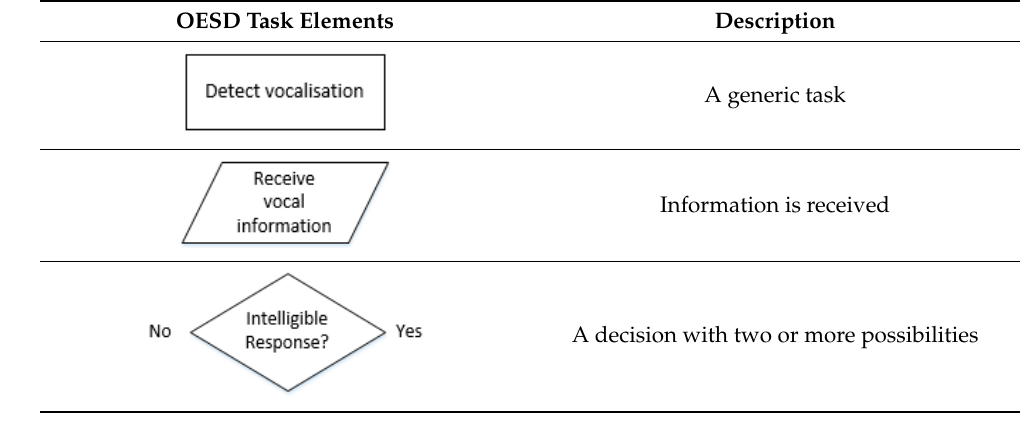
Table 1. Key for the Operator Event Sequence Diagrams.